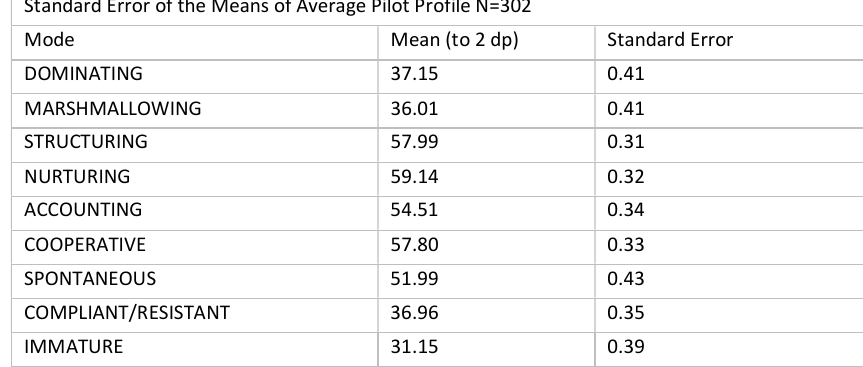
Table 2: Standard Error of the Mode Means of the Average Pilot Profile Standard Error of the Means of Average Pilot Profile N=302 Mode Mean (to 2 dp) DOMINATING